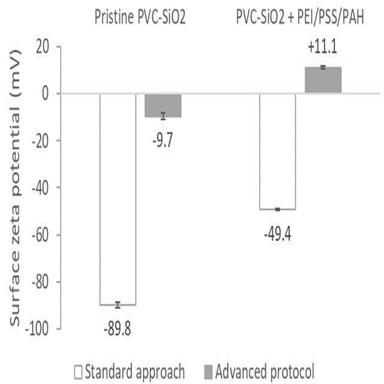
Surface zeta potential of PVC-SiO2 calculated with the standard approach and the advanced protocol; Solution: 0.001 M KCl at pH 5.60 ± 0.05.